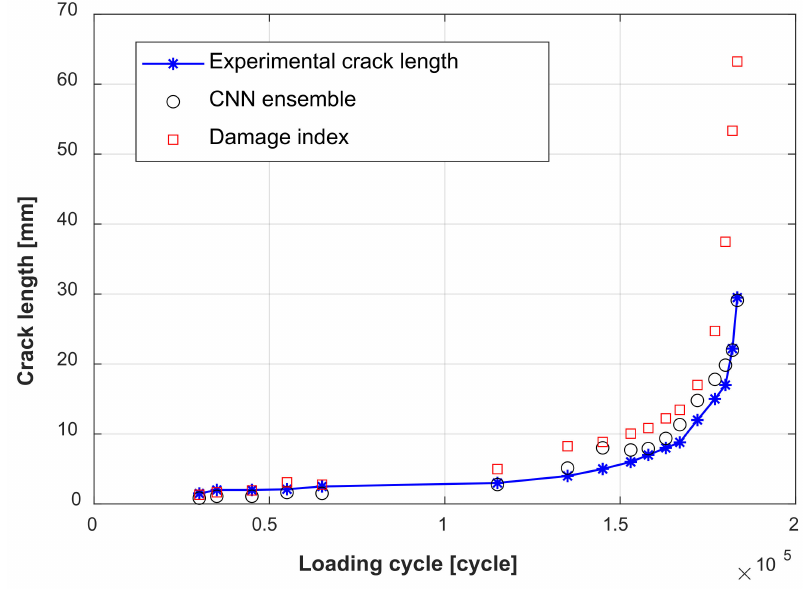
Figure 17. Fatigue crack evaluation result compared with the damage index-based